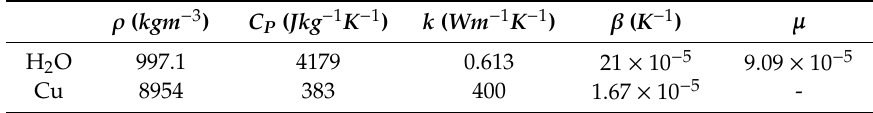
Table 1. Properties of H 2 O and Cu